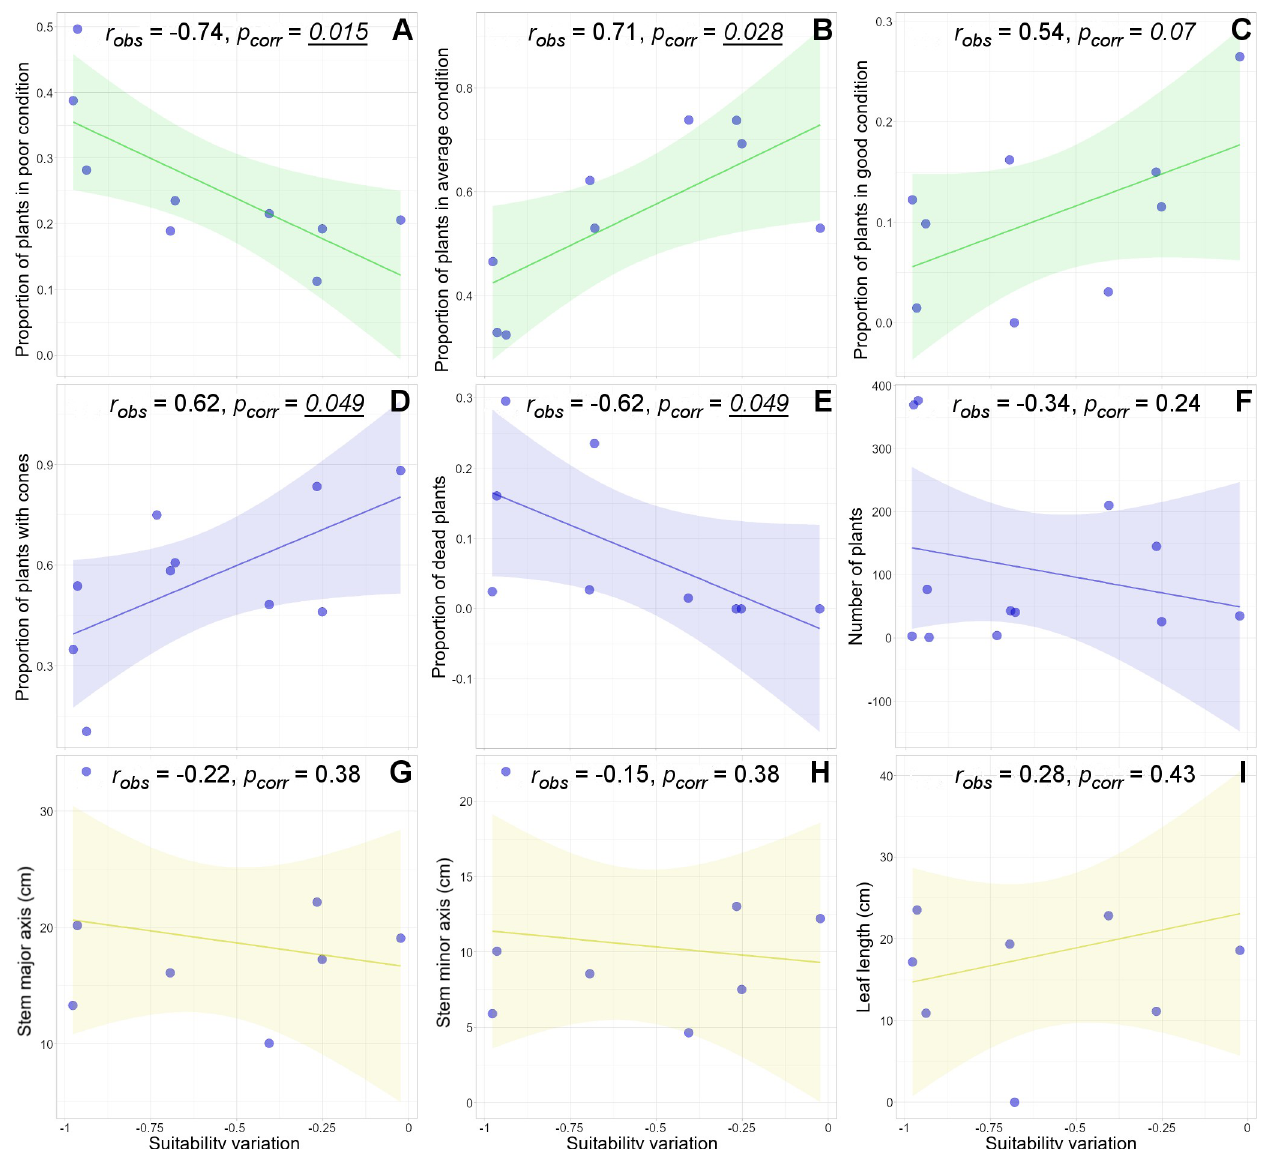
Fig 5. Linkage between population features and the expected suitability variation. Plots of the proportion of plants in poor (A), average (B), and good conditions (C), the proportion of plants with cones (D), the proportion of dead plants (E), the number of plants (F), the stem major (G) and minor axis (H), and the leaf length (I) as functions of the expected suitability variation in the stands. In all the plots, blue dots are values for plant stands, colored lines and areas represent the regression lines and the confidence intervals respectively, and the texts on the top of the plots indicate the results of the null-model correlation analyses (Pearson r and corrected p values for multiple comparisons). Note that suitability variation values (X-axis) are all negative; thus, the reduction of suitability increases from right to left.